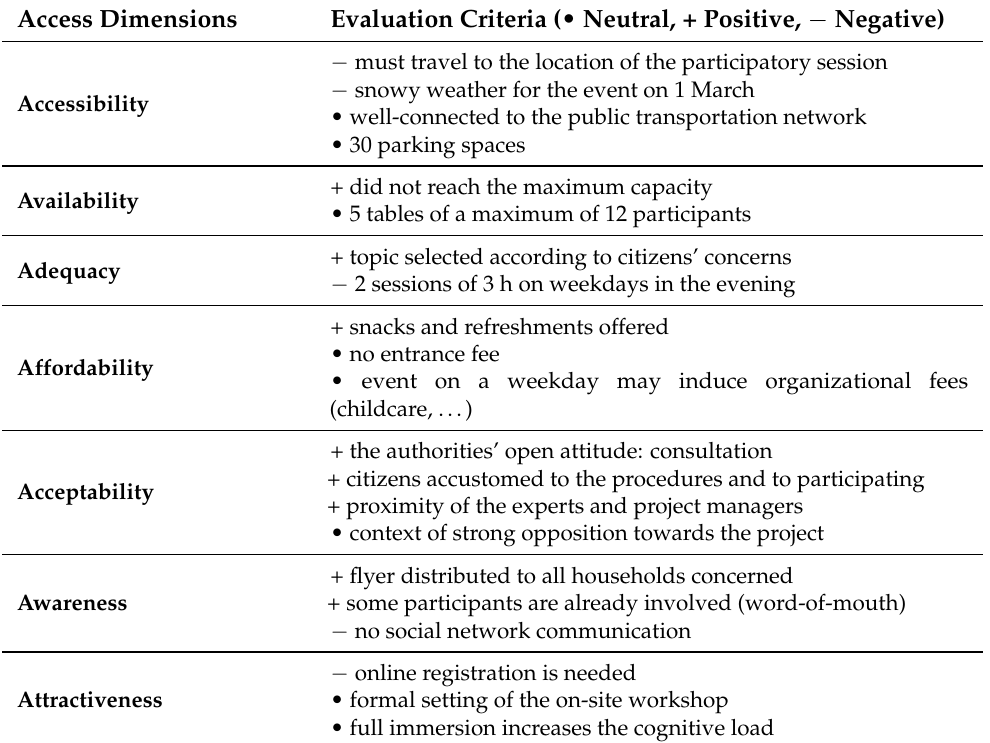
Table 4. Argumentative table of the access dimensions’